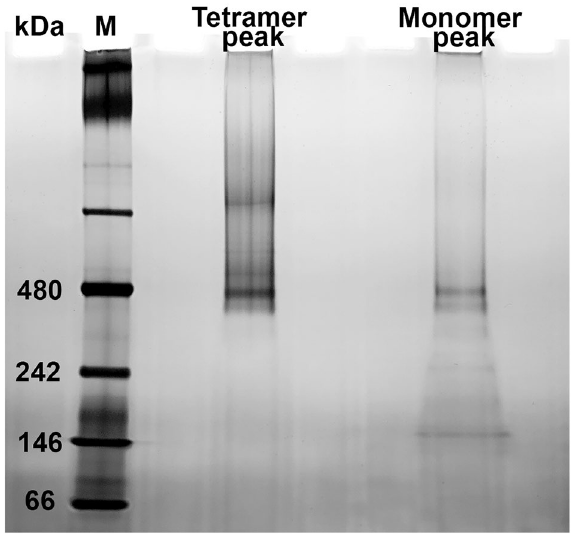
Figure 8. Silver stain of high resolution clear-native PAGE from pGC-A Superose 6 fractions. Superose 6 column eluted tetramer (480 kDa) and monomer (120 kDa) size peaks were concentrated and analyzed in a 4–16% native gel. M,